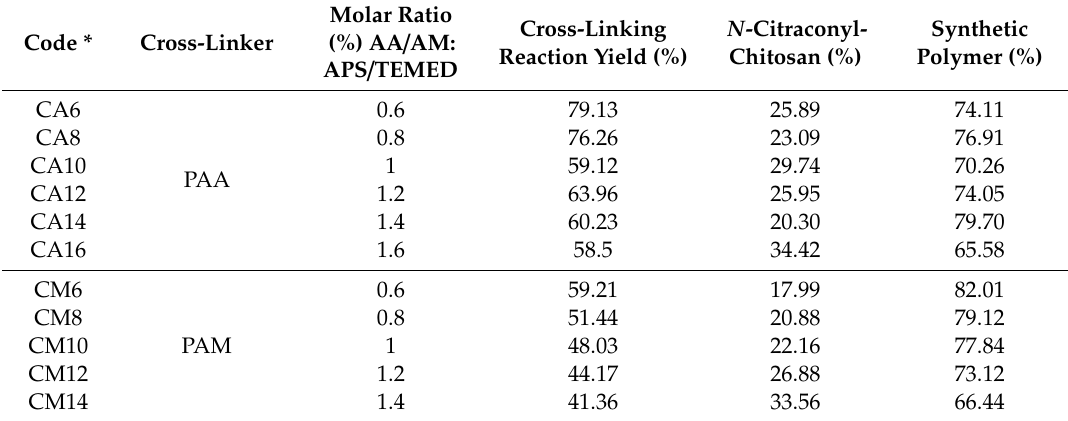
Table 1. Hydrogels composition, the cross-linking reaction yield, and final chitosan and synthetic polymer content present in 100% hydrogel, as determined by elemental